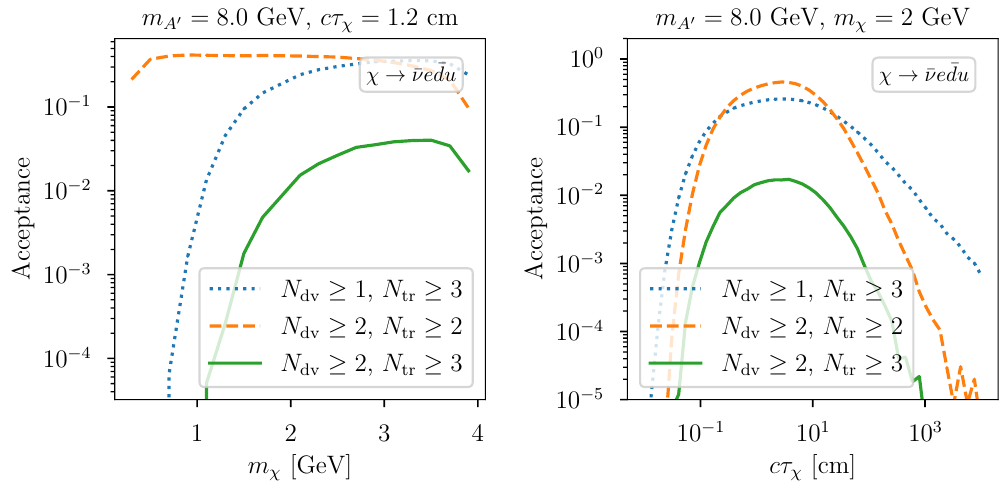
Figure 7 . Slices of the event acceptance probability for LLPs χ decaying to νe + hadrons for dark photon production with m = 8 GeV . The left (right) panel shows the acceptance as a function of A 0 the LLP mass for cτ = 1 . 2 cm (as a function of cτ for m = 2 GeV χ χ χ